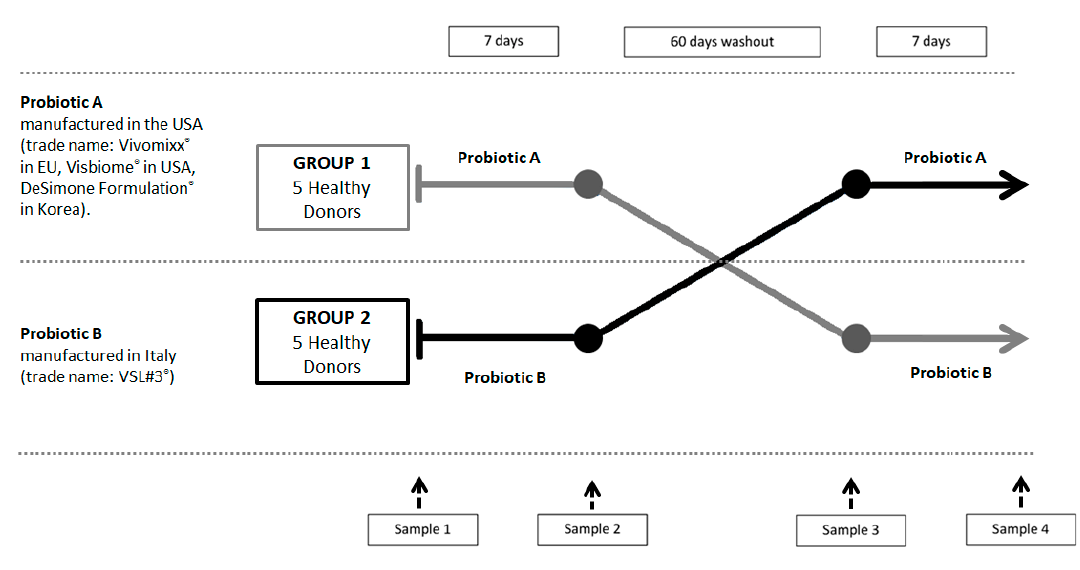
Figure 1. Protocol Figure 1. Protocol flow-chat.